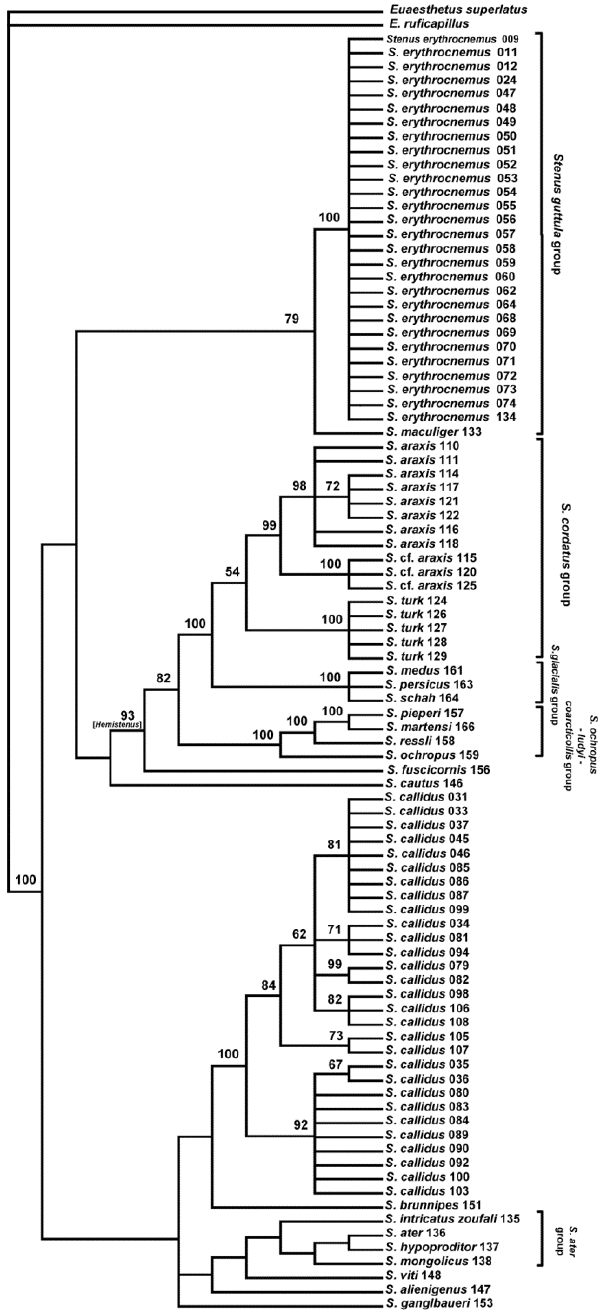
Figure 7. Strict consensus of most-parsimonious trees. Values above the branches indicate clade boot- strap support (>50) using 1000 replicates. The geographical origin of the specimens is coded by numbers behind the species name which correspond to the geographical information in Table